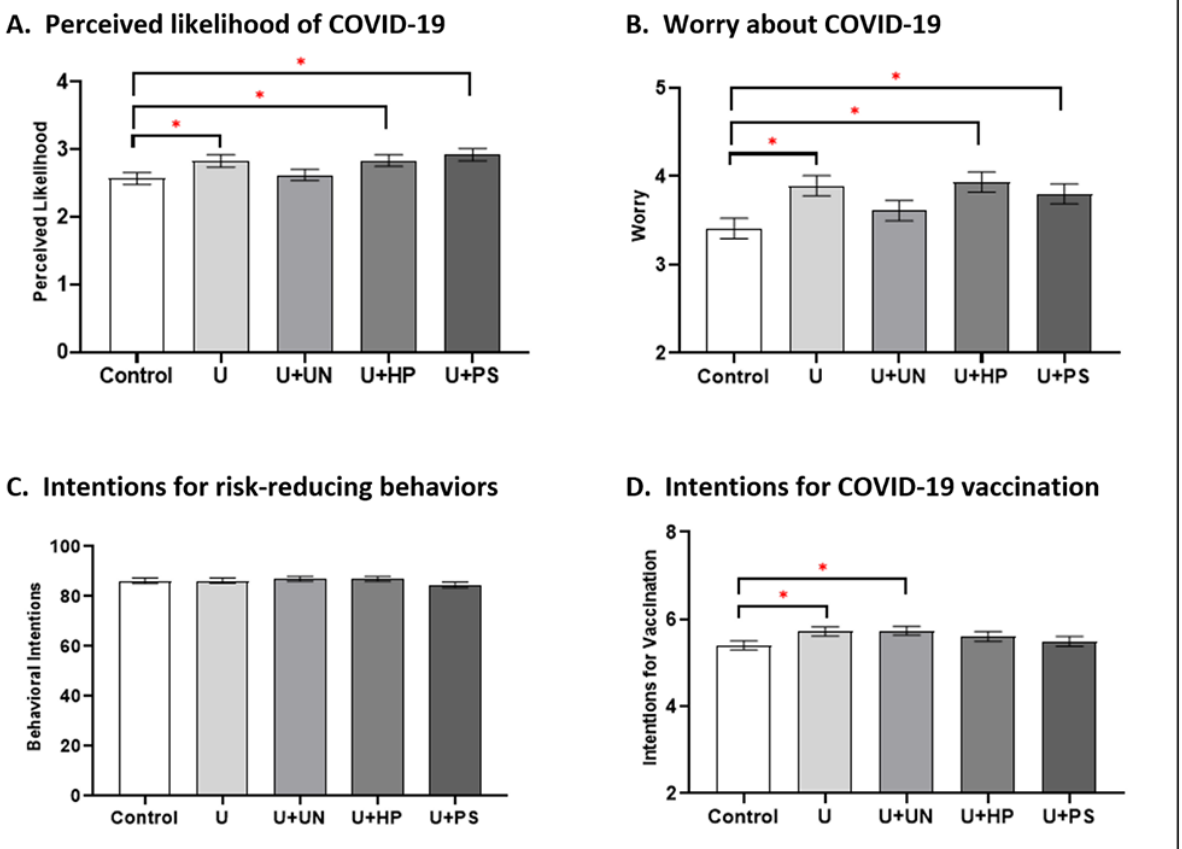
Figure 2. Effects of uncertainty and uncertainty communication strategies on cognitive, emotional, and behavioral manifestations of ambiguity aversion. Asterisks indicate statistically significant pairwise differences ( P <.05); error bars indicate standard error. U: uncertainty; U+HP: uncertainty